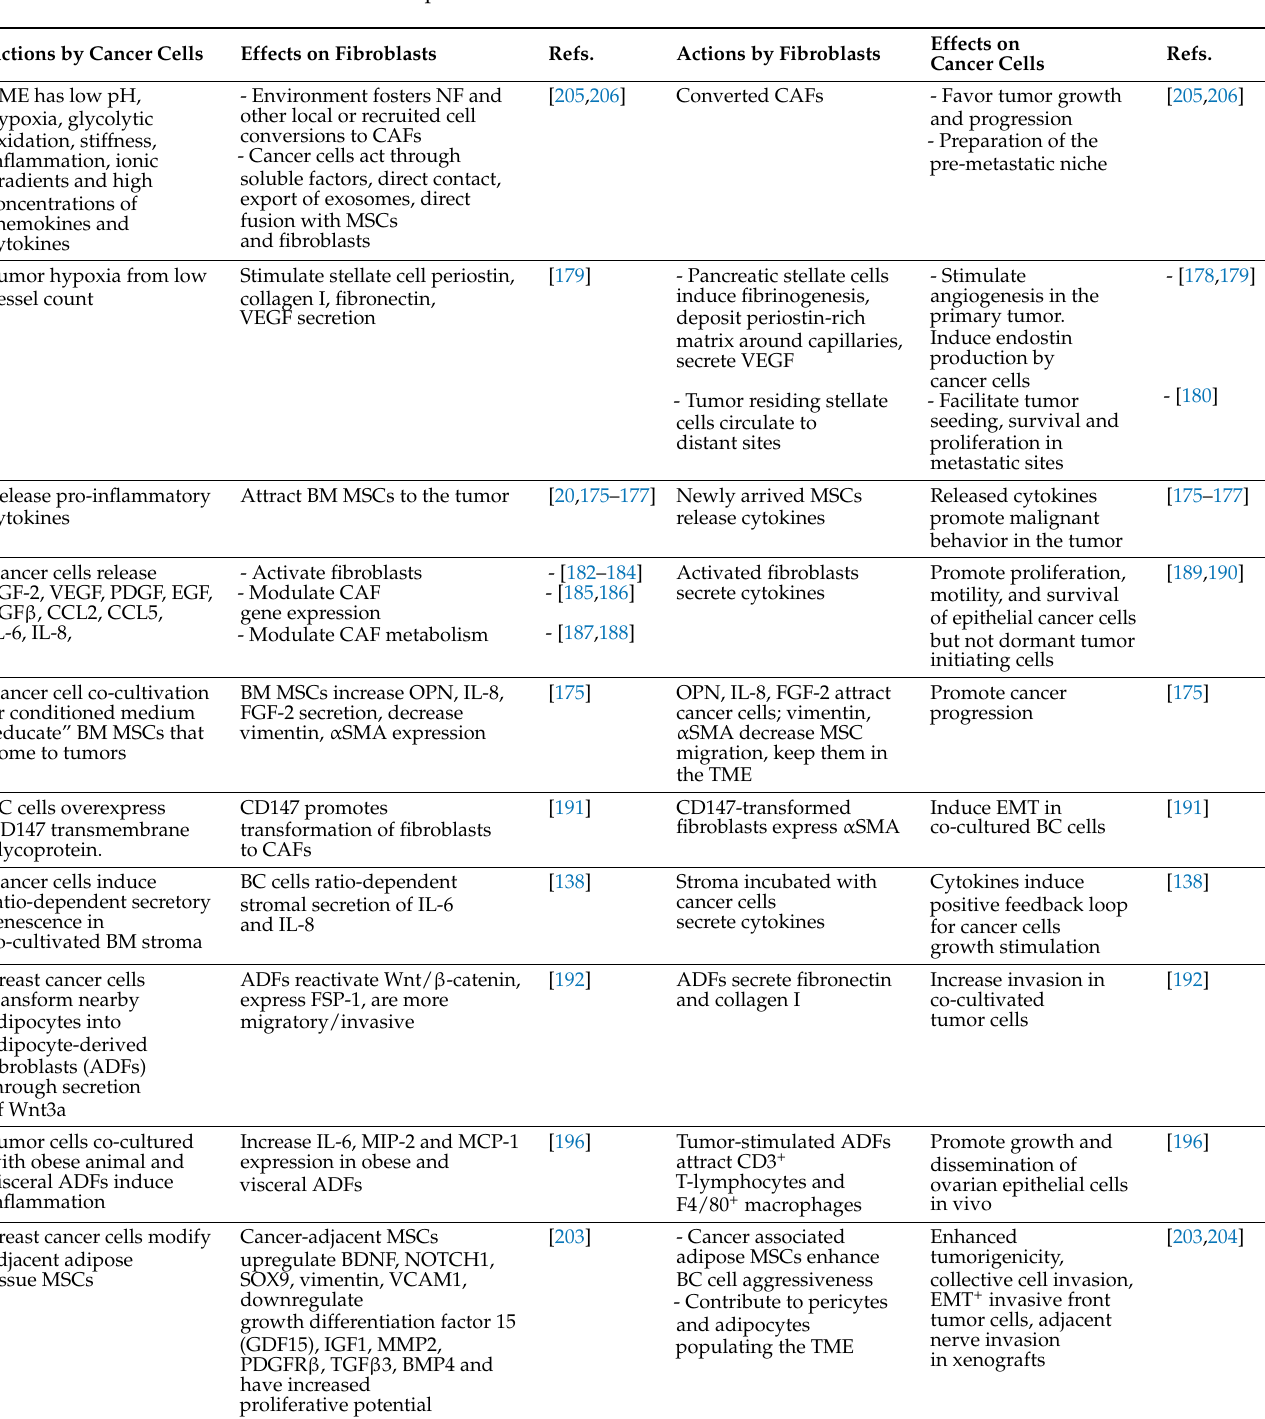
Table 2. Reciprocal effects of cancer cells and stromal